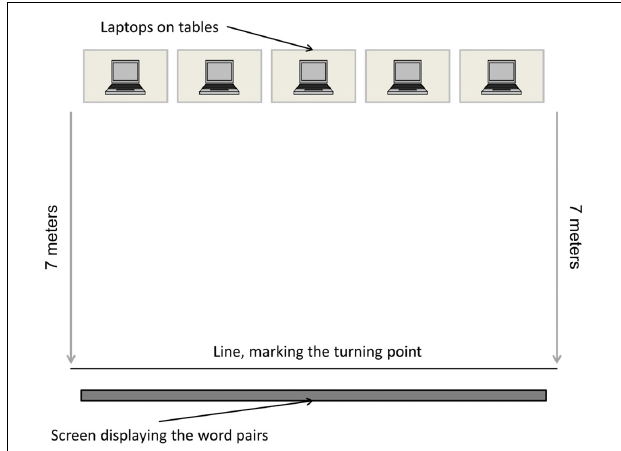
FIGURE 1 | Experimental setup of the vocabulary learning